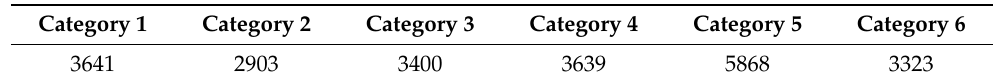
Table 2. Number of various